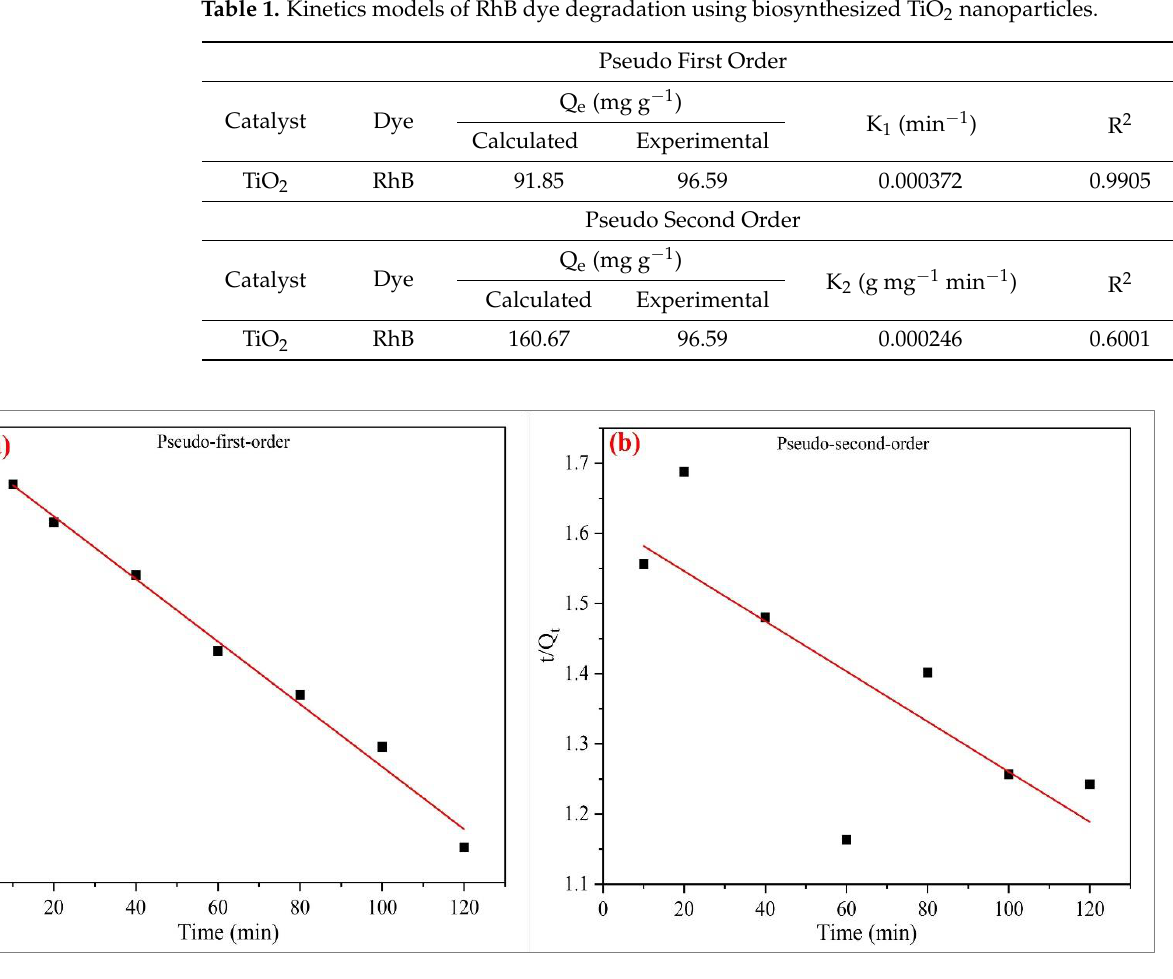
Figure 9. Plots of kinetic models showing degradation of RhB dye; ( a ) pseudo-first-order, ( b ) pseudo-second-order. Table 1. Kinetics models of RhB dye degradation using biosynthesized TiO 2 nanoparticles.